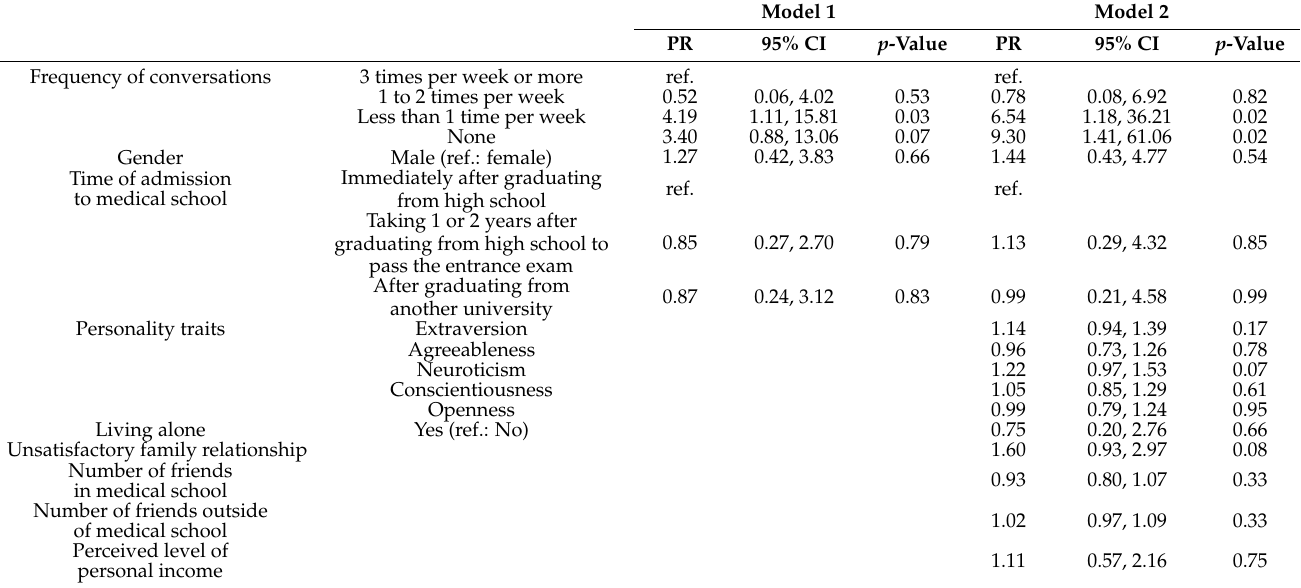
Table 2. Results of Poisson regression analysis about the prevalence of suicidal